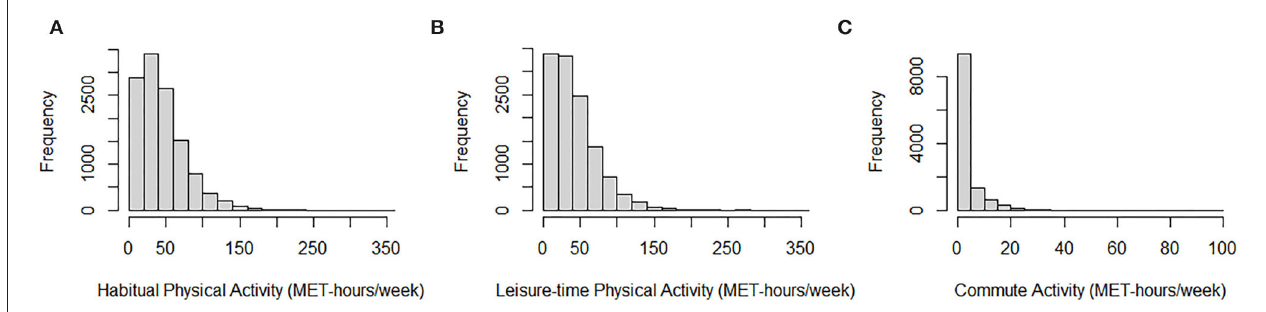
FIGURE 1 | Histograms of habitual physical activity, leisure-time physical activity, and commute activity. (A) Histogram of habitual physical activity among all participants. (B) Histogram of leisure-time physical activity among all participants. (C) Histogram of commute activity among all participants.